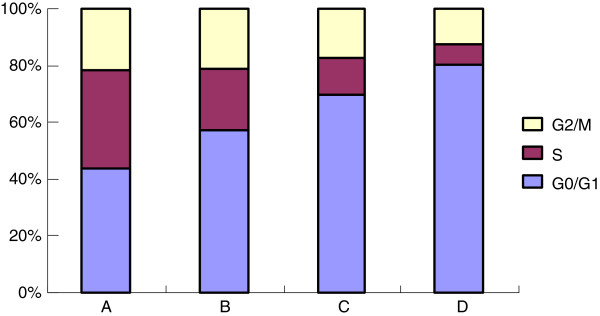
Effects of celecoxib on the cell cycle of MCF-7 cells by flow cytometry. A: control group; B: 10 μmol/L celecoxib; C: 20 μmol/L celecoxib; D: 40 μmol/L celecoxib. The cell cycle distributions in MCF-7 cells were determined by PI staining and flow cytometric analysis after treated with 0-40 μmol/L celecoxib for 48 h. Results presented were representative of three independent experiments.